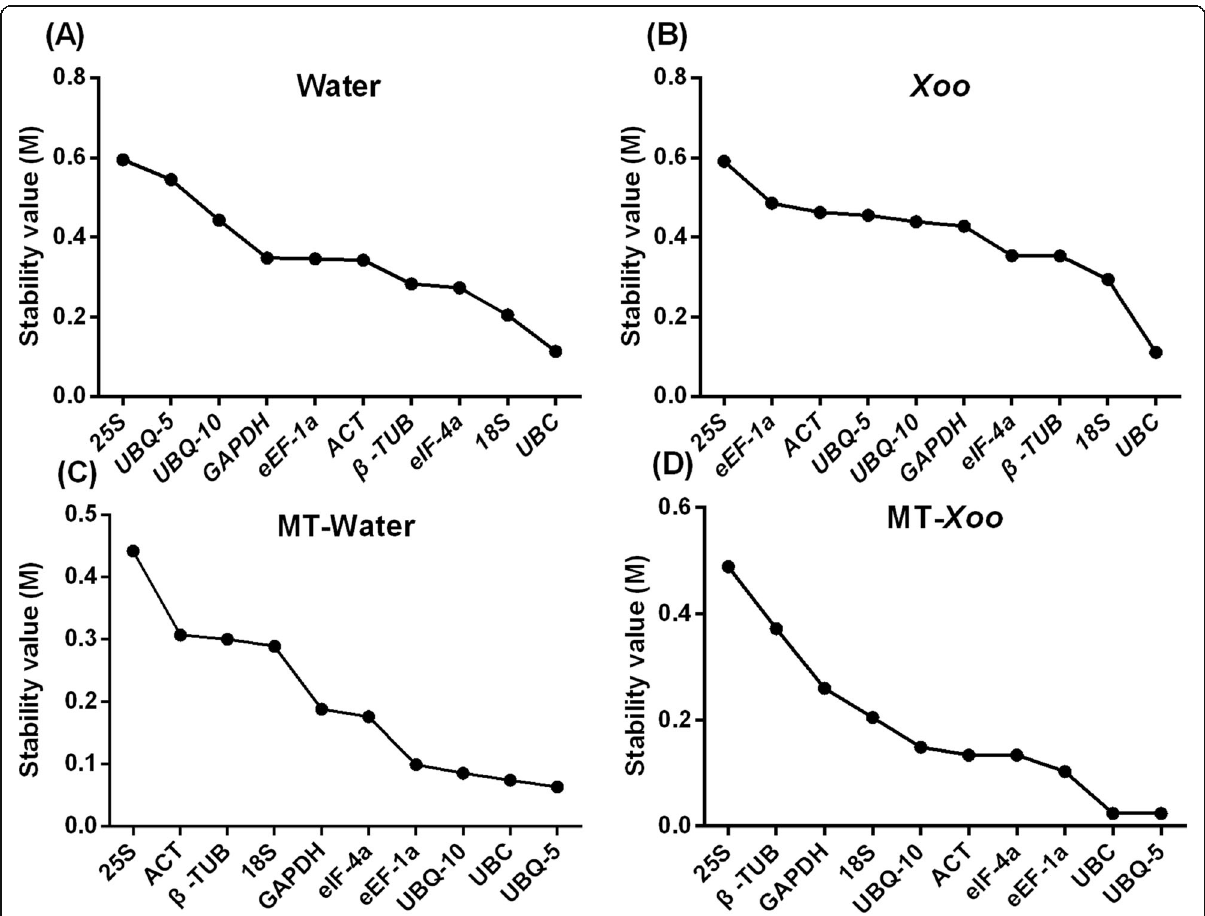
Fig. 4 Expression stability of the candidate reference genes assessed by NormFinder analysis. a - d Expression stability of candidate reference genes in water-inoculated rice plants, in Xoo -inoculated rice plants, in MT-water infected rice plants and in MT- Xoo infected rice plants